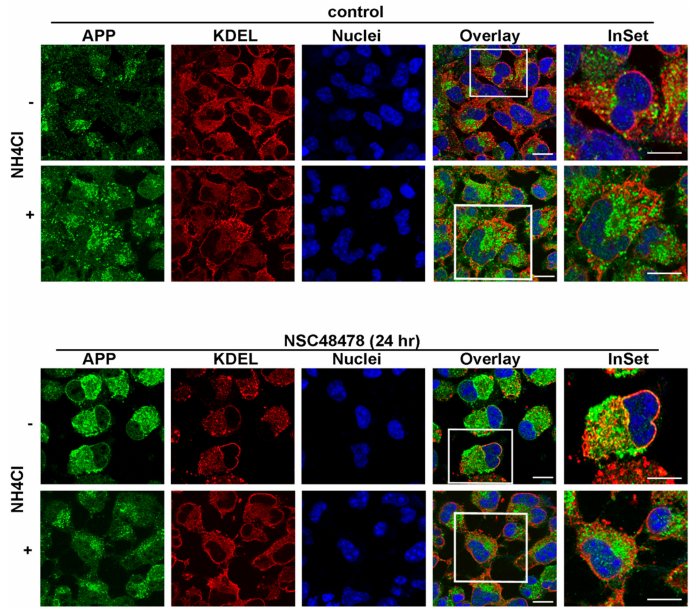
Figure 7. NH 4 Cl rescues inhibitor e ff ects on APP subcellular localization. GT1 cells grown on coverslips were treated or not with the inhibitor NSC48478 in the presence or absence of NH 4 Cl. GT1 cells were subjected to immunofluorescence analysis by using anti-KDEL and anti-APP antibodies. Colocalization between APP and KDEL was then measured as indicated in the methods section. Plus + ) and minus (-) indicate the presence or absence of NH 4 Cl. Scale bars, 10 µ